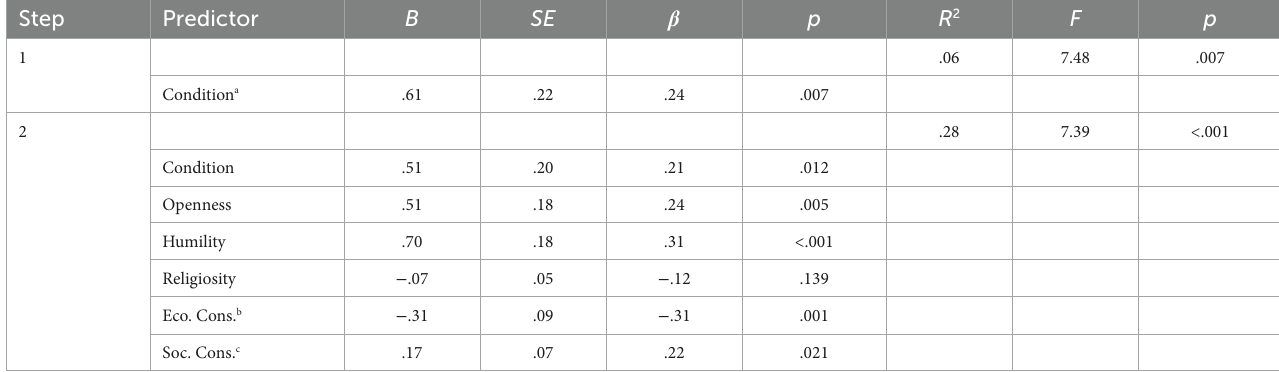
TABLE 4 Hierarchical linear regression of condition (awe vs. control) and personality in predicting levels of moral expansiveness in Study 4.